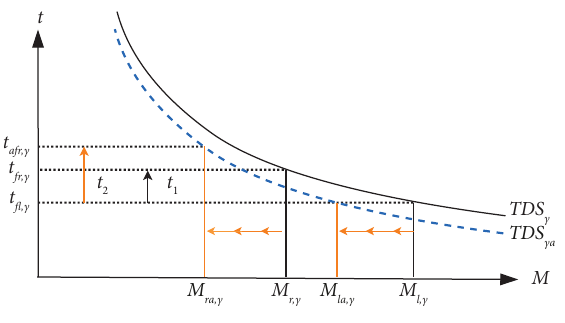
Figure 5: Adaptive TDS estimation.